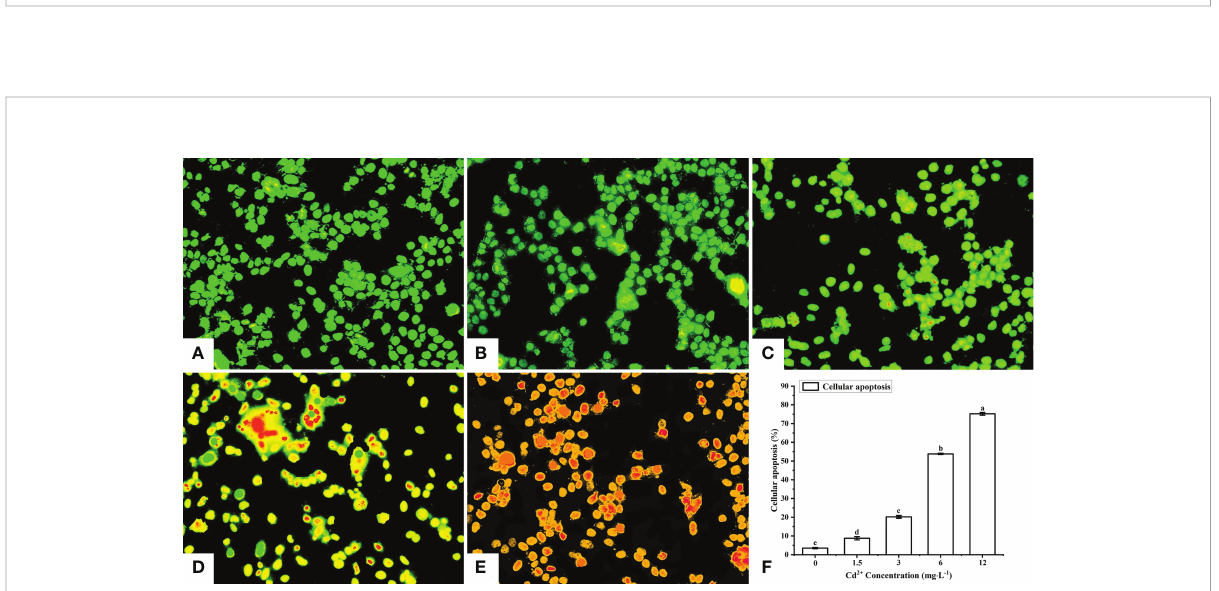
FIGURE 3 Detection of apoptotic M. meretrix ovarian cells by fl uorescence microscopy following exposure to Cd 2+ . (A) control group; (B) 1.5 mg L − 1 ; (C) 3 mg L − 1 ; (D) 6.0 mg L − 1 ; (E) 12 mg L − 1 Cd 2+ concentration. (F) The plot shows the rate of apoptosis in M. meretrix ovarian cells as determined from the microscopy data. Signi fi cant ( P < 0.05) differences among groups are indicated by different letters above the bars in the plot.